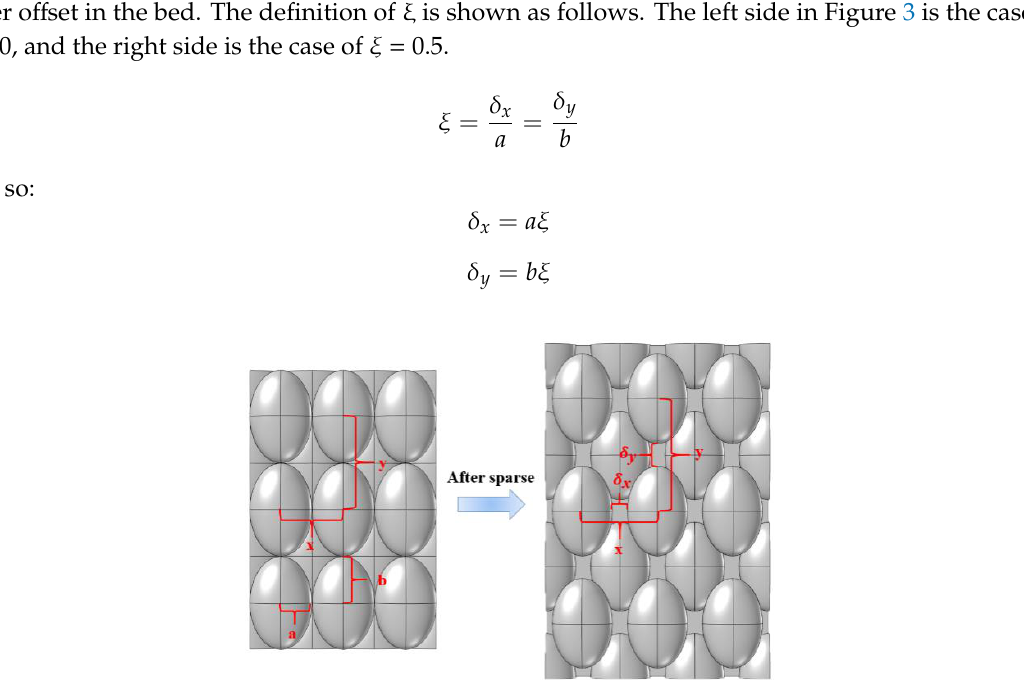
Figure 3. Top view of the multilayer ellipsoid pellet bed distribution. Figure 3 . Top view of the multilayer ellipsoid pellet bed distribution. Figure 3 . Top view of the multilayer ellipsoid pellet bed distribution.